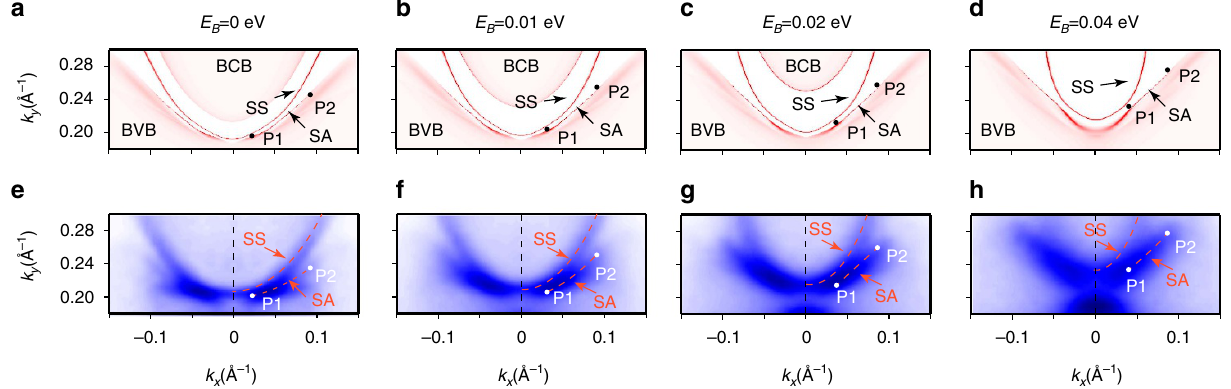
Figure 4 | Evolution of the Fermi arcs with binding energies. ( a – d ) Evolution of the projection of the Fermi arcs in the calculation at E B ¼ 0, 0.01, 0.02 and 0.04eV, respectively. The regular surface state and the surface Fermi arc are labelled as SS and SA, respectively; points P1 and P2 indicate the starting and ending points of the surface Fermi arcs. ( e – h ) Photoemission intensity map in the same area as in a – d . The dashed lines show the surface state (SS) and the surface Fermi arcs (SA), corresponding to those in a – d